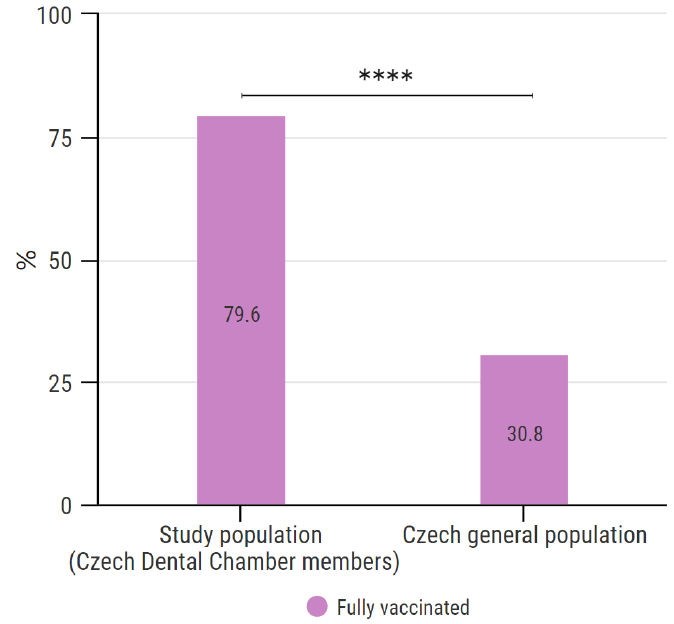
Figure 6. Comparison of full COVID-19 vaccination within the study population and Czech general population. **** indicates p < 0.0001, chi-square with Yates’ correction, OR = 8.167, 95% CI 7.438 to 8.966).